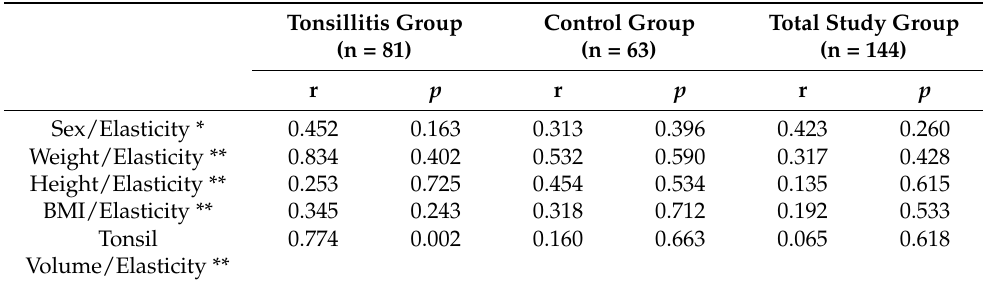
Table 3. Correlation analyses between elasticity and sex, weight, height, body mass index (BMI), tonsil volume (r = correlation coefficient; p = statistical